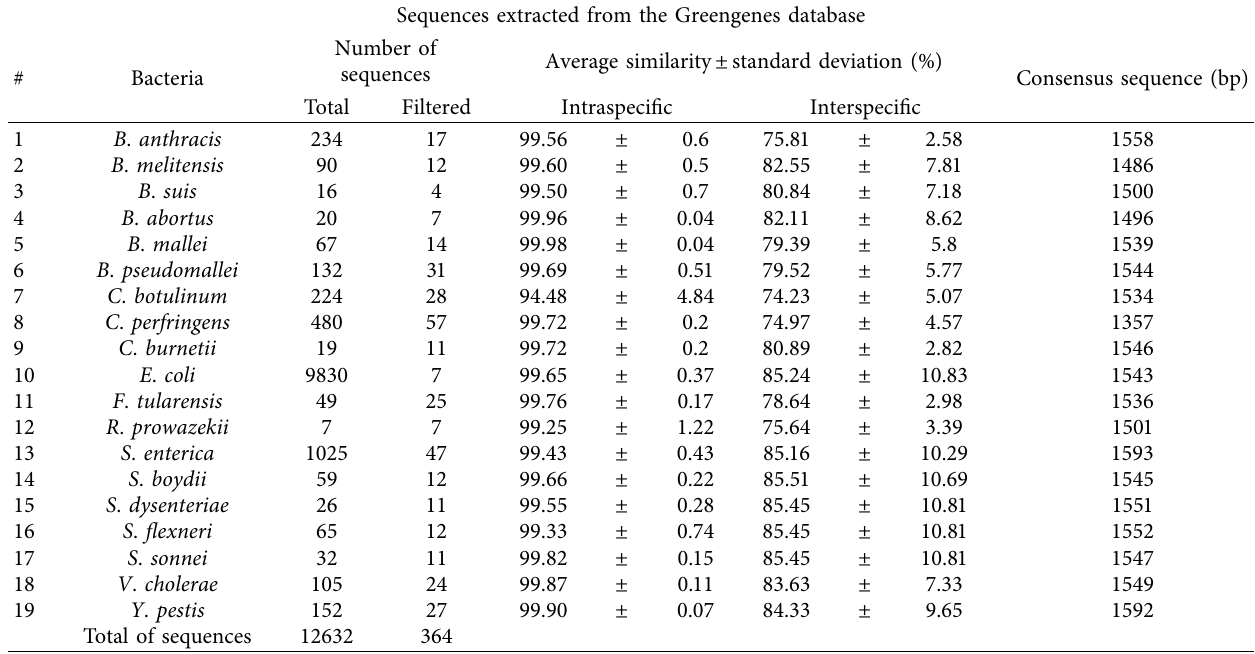
Table 1: Intraspecific and interspecific genetic similarity values of 16S rRNA gene. Sequences extracted from the Greengenes database